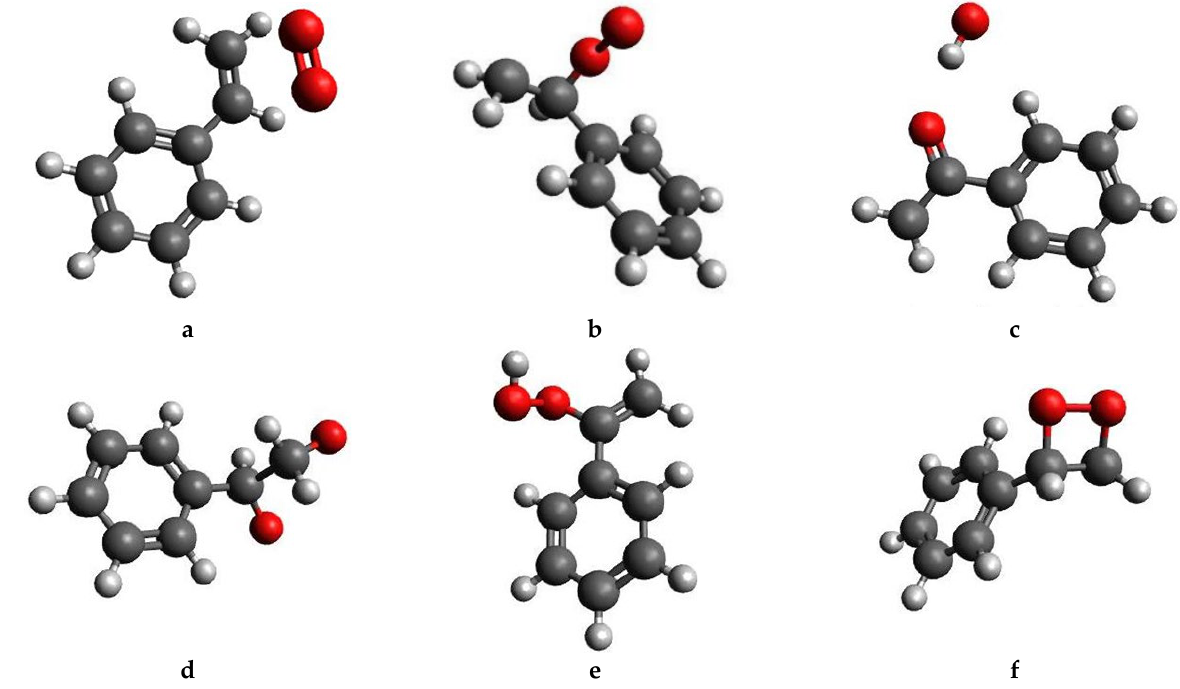
Figure 6. Structures emerging during the reaction of formation and evolution of radical pairs during auto initiation of styrene oxidation: a —IT, ∆ E = − 20.8 kJ/mol; b —IIT, ∆ E = 74.6 kJ/mol; c —IIT, ∆ E = − 33.0 kJ/mol; d —IVT, ∆ E = 289.5 kJ/mol; e —IS, ∆ E = − 80.9 kJ/mol; f —IIS, ∆ E = − 46.3 kJ/mol. For each structure, the values of the change in its energy ( ∆ E) with respect to the sum of the total electronic energies of isolated styrene and oxygen molecules are indicated. The T symbol at the Roman numeral corresponding to the structure number indicates a triplet state; the S symbol is a singlet state. The IT structure is an initial pre-reaction complex. Structure III is an internal radical pair that occurs when a diatomic oxygen molecule is attached to one of the carbon bonds of a styrene molecule. The IVT structure is a radical pair that occurs when an oxygen molecule is attached to a styrene double bond by two atoms simultaneously. In [19], it was assumed that the IVT structure emerges during the transformation of the IIT structure. However, as can be seen from the energy changes values, this process is unlikely and the process leading to the IIIT structure is more likely. Both radical pairs IVT and IIIT can initiate two kinetic oxidation chains; however, the difference between them is that in the case of the IVT structure, these kinetic chains will start on the same molecule, whereas in the case of the IIIT structure, they will start on two different molecules. The second molecule initiating the chain, in this case, will be a hydroxyl radical. When a constant magnetic field is applied, T–S transitions will be initiated, which in this reaction can be both T + → S and T − → S depending on the magnetic field strength, and with increasing field strength, the proportion of T − → S transitions should decrease. Since these transitions will lead to the formation of molecular compounds, the share of radical pairs involved in the initiation of oxidation chains will decrease and the MFE sign will be